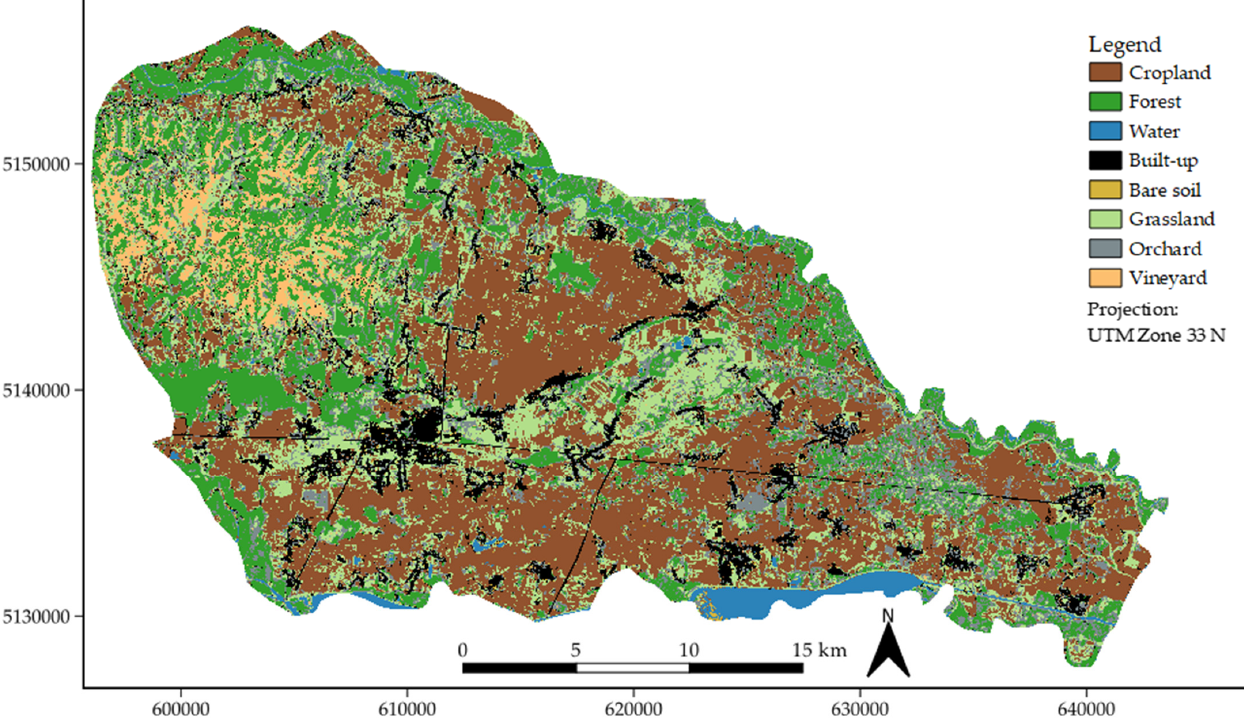
Figure 7. Classification map of the Me đ imurje County produced by RF using S1 with S2 imagery.